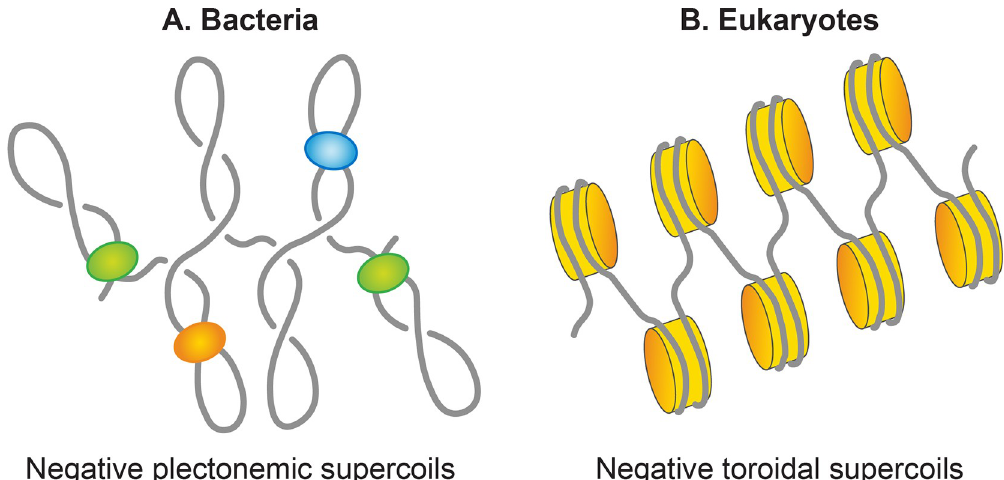
Fig 5. Basic units of genomic organization in bacteria and eukaryotes. A. A bacterial genome organizes as plectonemic supercoils. Half of the supercoils are present in free form, and nucleoid-associated proteins (NAPs), shown as colored spheres, restrain the remaining half. B. In contrast, a eukaryotic genome organizes as toroidal supercoils, induced by the wrapping of DNA around histone proteins (orange color). An octamer of histones with 146 wrapped DNA refers to as nucleosome, and the genome organizes into a repeating array of nucleosomes.